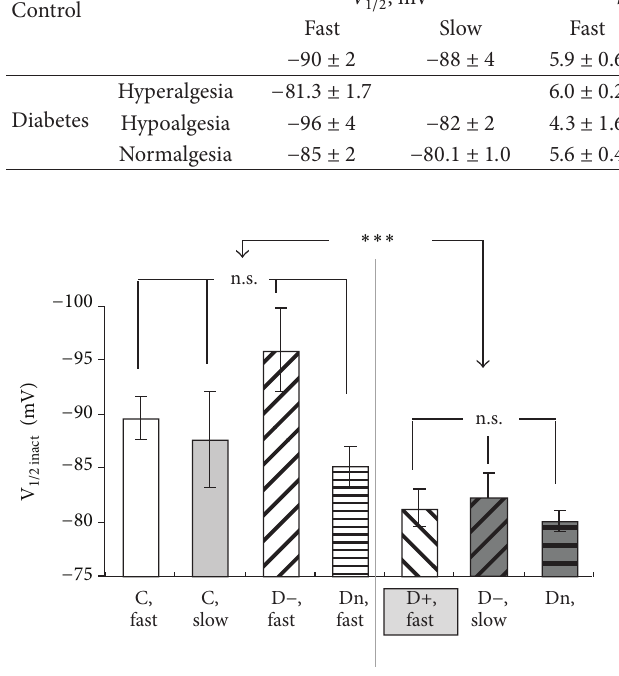
Figure 4: PDN-specific changes in steady-state inactivation of T- currents in NTCN neurons. Each column demonstrates the mean and SEM of half-inactivation potential of steady-state inactivation (SSI) calculated for 13 “fast” and 7 “slow” neurons of control group (C), 7 neurons of hyperalgesic group (D+), 5 “fast” and 3 “slow” neurons of hypoalgesic group (D − ), and 8 “fast” and 4 “slow” neurons of normalgesic group (Dn). The results demonstrate that a depolarization shift in SSI was observed for the fast T-current in a case of hyperalgesia and for the slow T-current in norm- and hypoalgesia. ANOVA between all columns produced 𝑃 < 0.02 . ∗∗∗ 𝑃 < 0.001 ( 𝑡 -test for merged “C, fast,” “C, slow,” and “D − , fast,” “Dn, fast” versus merged “D+, fast,” “D − , slow,” and “Dn, slow”). n.s.: not significant